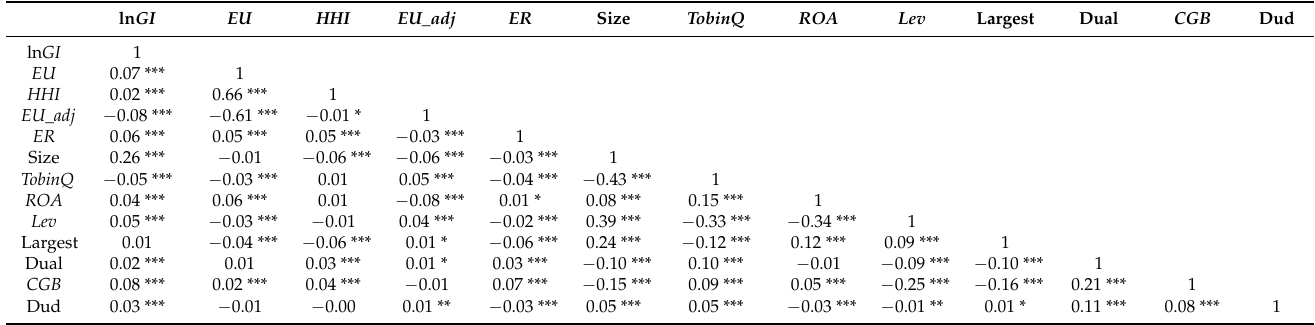
Table 3. Correlation analysis of the main variables.